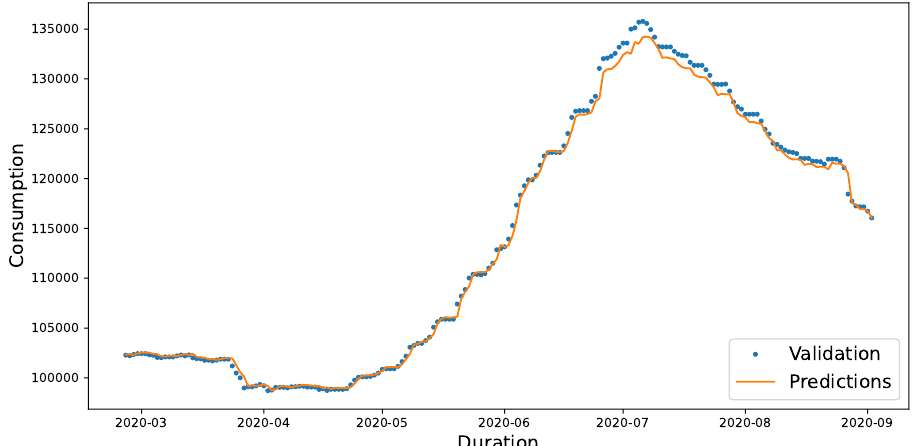
Figure 10. Close view of Figure 9b for validation and prediction